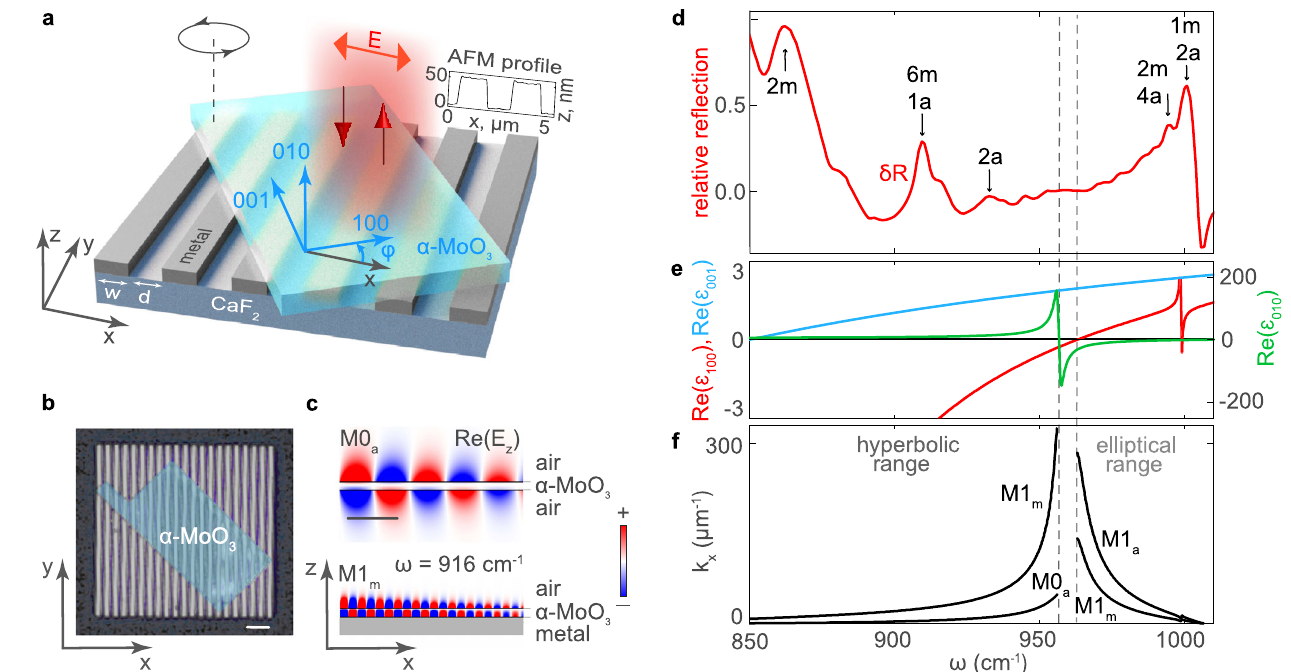
Fig. 1 PhP nanoresonators in α -MoO 3 de fi ned by placing a pristine α -MoO 3 slab on metallic ribbons. a Schematics of the studied structure that allows de fi ning the nanoresonators by “ electromagnetic engineering ” and controlling them by a twist angle, φ . The inset shows the AFM pro fi le of the metal grating. b False-color optical image (top view) of the sample consisting of a 110 nm-thick α -MoO 3 slab placed on a 50 nm- thick metal grating. Scale bar: 8 μ m. c Simulated fi eld distributions of the M0 and M1 PhP modes in the α -MoO 3 /air (top) and α -MoO 3 /metal (bottom) regions. d Relative far- fi eld re fl ection spectrum of the PhP nanoresonators for φ ¼ 0 °. The subscripts “ a ” and “ m ” indicate the PhP resonances originated in the α -MoO 3 /air and α -MoO 3 /metal regions, respectively. e Real part of the dielectric permittivity tensor components as a function of ω . f Calculated dispersion of the M1 and M0 modes shown in ( c